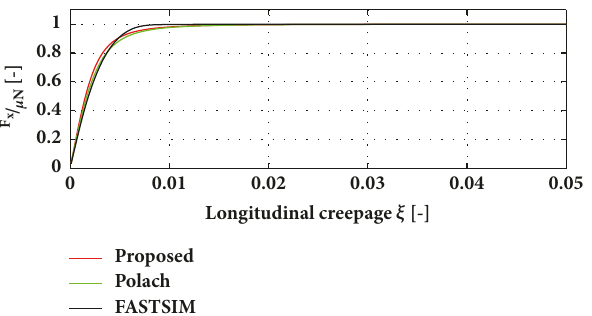
Figure 11: Lateral force versus spin creepage in presence of a constant lateral creepage ( 𝜂 =